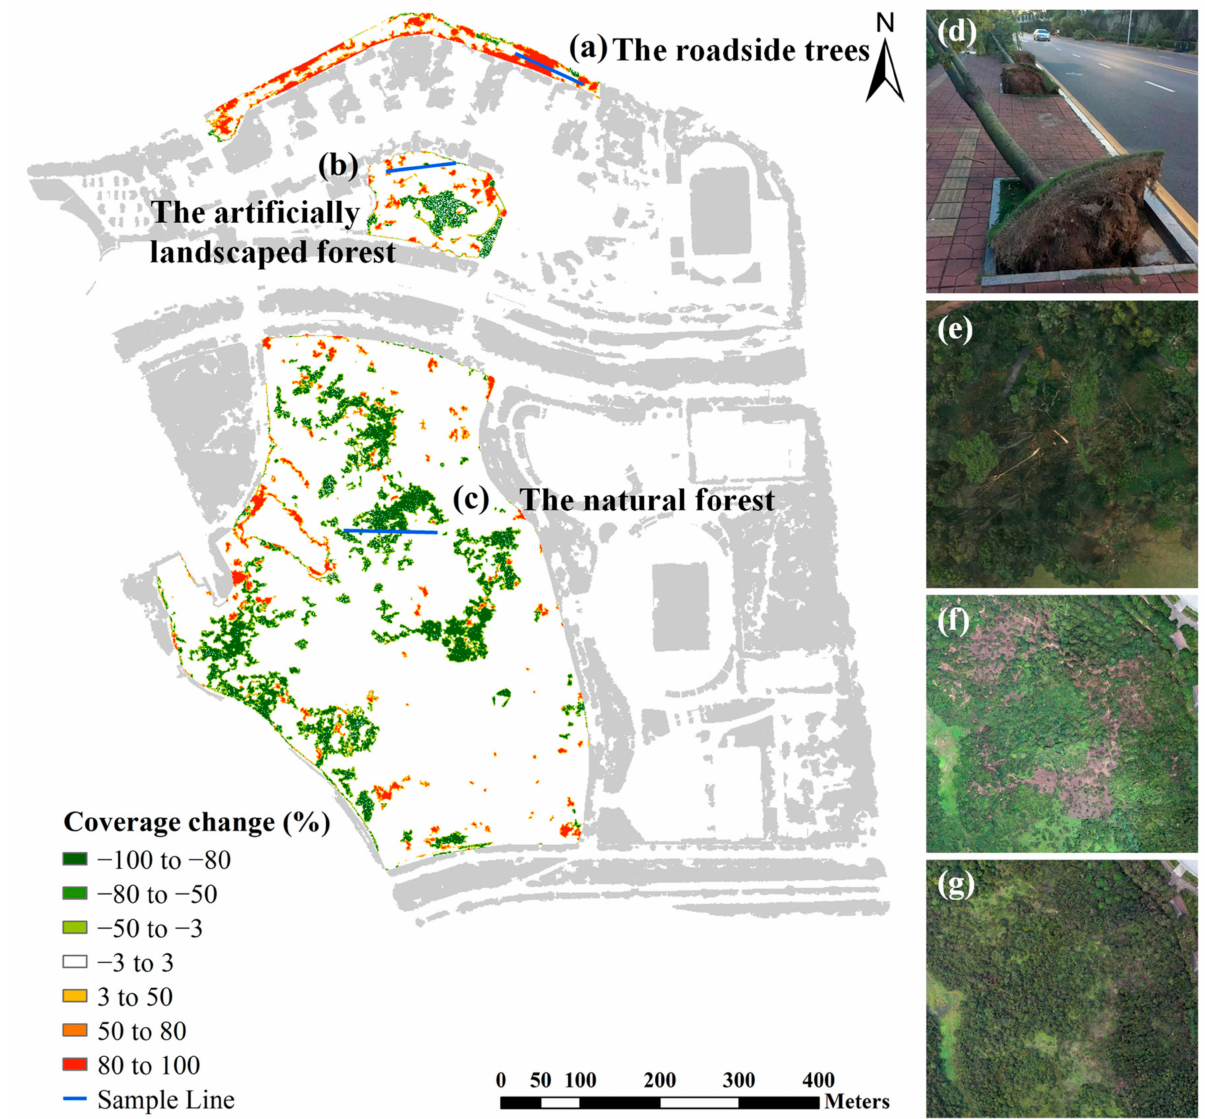
Figure 3. Distribution of changes to urban vegetation coverage in the study area (GSD: 1 m). ( a ) Road- side trees; ( b ) artificially landscaped forest; ( c ) urban natural forest; ( d ) typhoon-damaged fallen roadside trees—mainly newly planted Bombax ceiba ; ( e ) damage caused to artificially landscaped forest; ( f ) pre-typhoon area of bare soil in an urban natural forest; and ( g ) post-typhoon area of bare soil covered by grasses. Note that urban vegetation coverage changes are the differences between pre- and post-typhoon vegetation coverage. The positive values indicate a decrease in urban vegetation coverage, while the negative values indicate an increase in urban vegetation